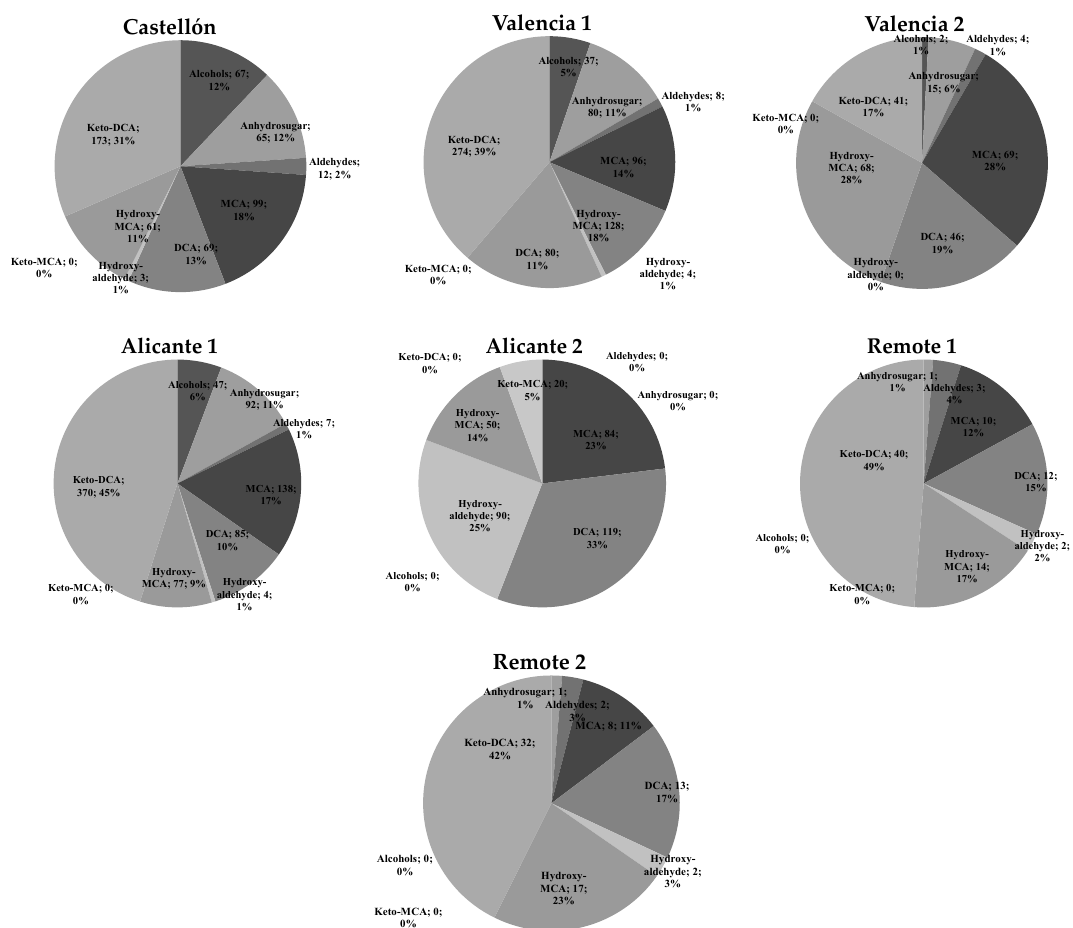
Figure 1. Relative contribution of different multi-oxygenated family species in the fine PM organic fraction at the five sampling sites. Values include average mass concentration (µg m − 3 ) of each family of oxygenated organic compound (OOCs) and its percentage contribution by sampling site. Castellón (urban site in the surroundings of an industrial area) ∑ OOCs: 549 ng m − 3 ; Valencia 1, (sub-urban place), ∑ OOCs: 707 ng m − 3 ; Valencia 2 (urban site) ∑ OOCs: 245 ng m − 3 ; location in the same city, 3 km from the sea. The fourth site was a near the city of Alicante 1 (sub-urban location in a commercial and residential zone) ∑ OOCs: 821 ng m − 3 ; and Alicante 2 (industrialized area) ∑ OOCs: 363 ng m − 3 . Remote area 1 ∑ OOCs: 85 ng m − 3 and Remote area 2 ∑ OOCs: 75 ng m − 3 were selected as low-OOCs SOA.